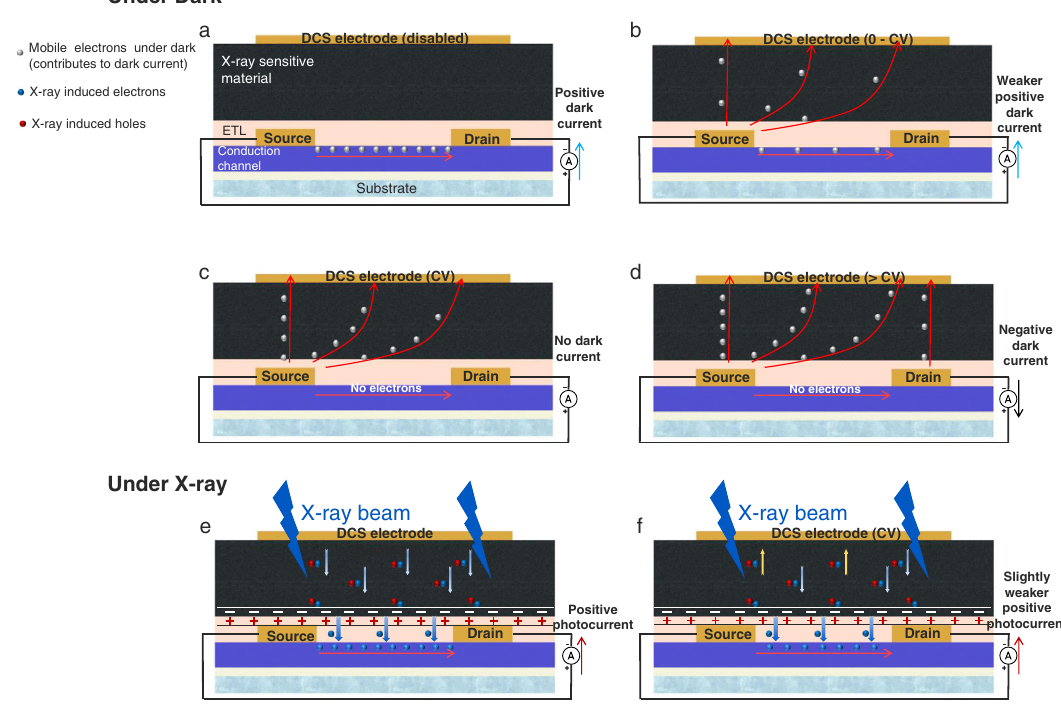
Fig. 2 | Detailed working principles of dark-current-shunting (DCS) X-ray detector. a Working principle at the dark condition and with DCS electrode disabled. The electrons emitted from the source transport through the conduc- tion channel,andarecollectedbythe drain,theDCSdetectorisworkingina two- terminal mode similar as a photoconductive detector. b Working principle at the dark condition and with DCS electrode applied with a small bias. Some electrons emittedfromthesourceareattractedbytheDCSelectrode,andthedraincollects fewer electrons than the case described in Fig. 2a, leading to a smaller dark current. c WorkingprincipleatthedarkconditionandwithDCSelectrodeapplied with a CV. The electrons emitted from the source are all attracted by the DCS electrode, and the drain will not receive any electrons, leading to zero dark current in principle. d Working principle at the dark condition and with DCS